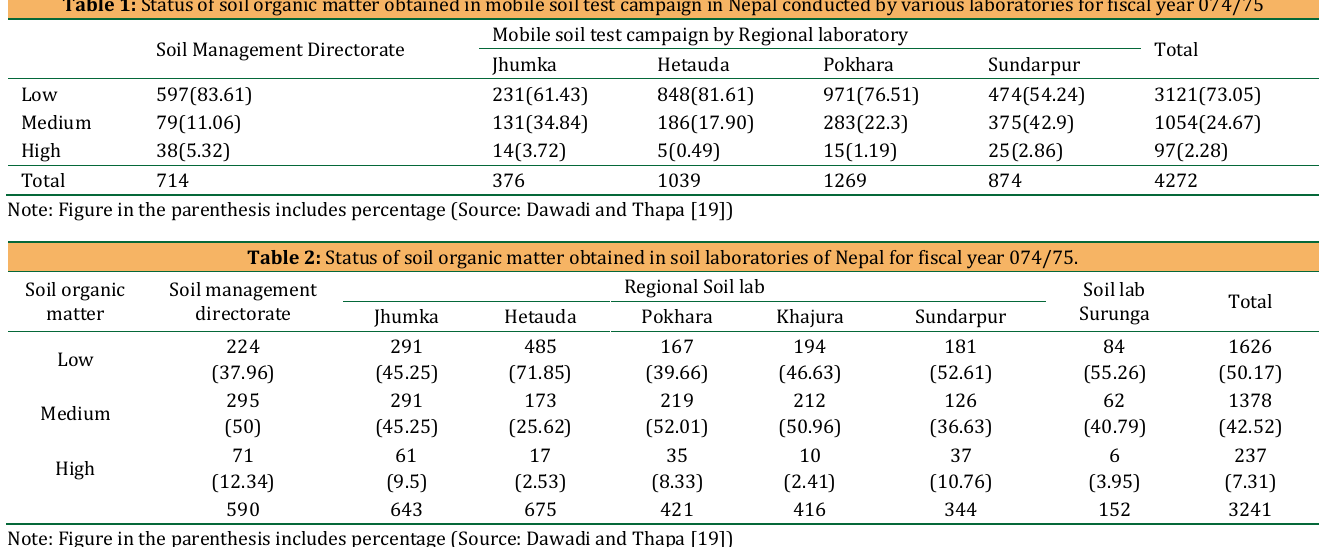
Status of soil organic carbon on samples studied by various soil labs of Nepal Soil management directorate conducted 18 mobile soil campaign, regional soil test lab (RSTL) at Jhumka, Hetauda, Pokhara and Sundarpur conducted each of 10 mobile soil campaign and RSTL, Khajura conducted 14 such campaigns. The result of those campaigns is shown in table 1. Total of 73.05% of samples showed low organic matter, 24.67% samples contained medium organic matter and only 2.28% were with high organic matter.